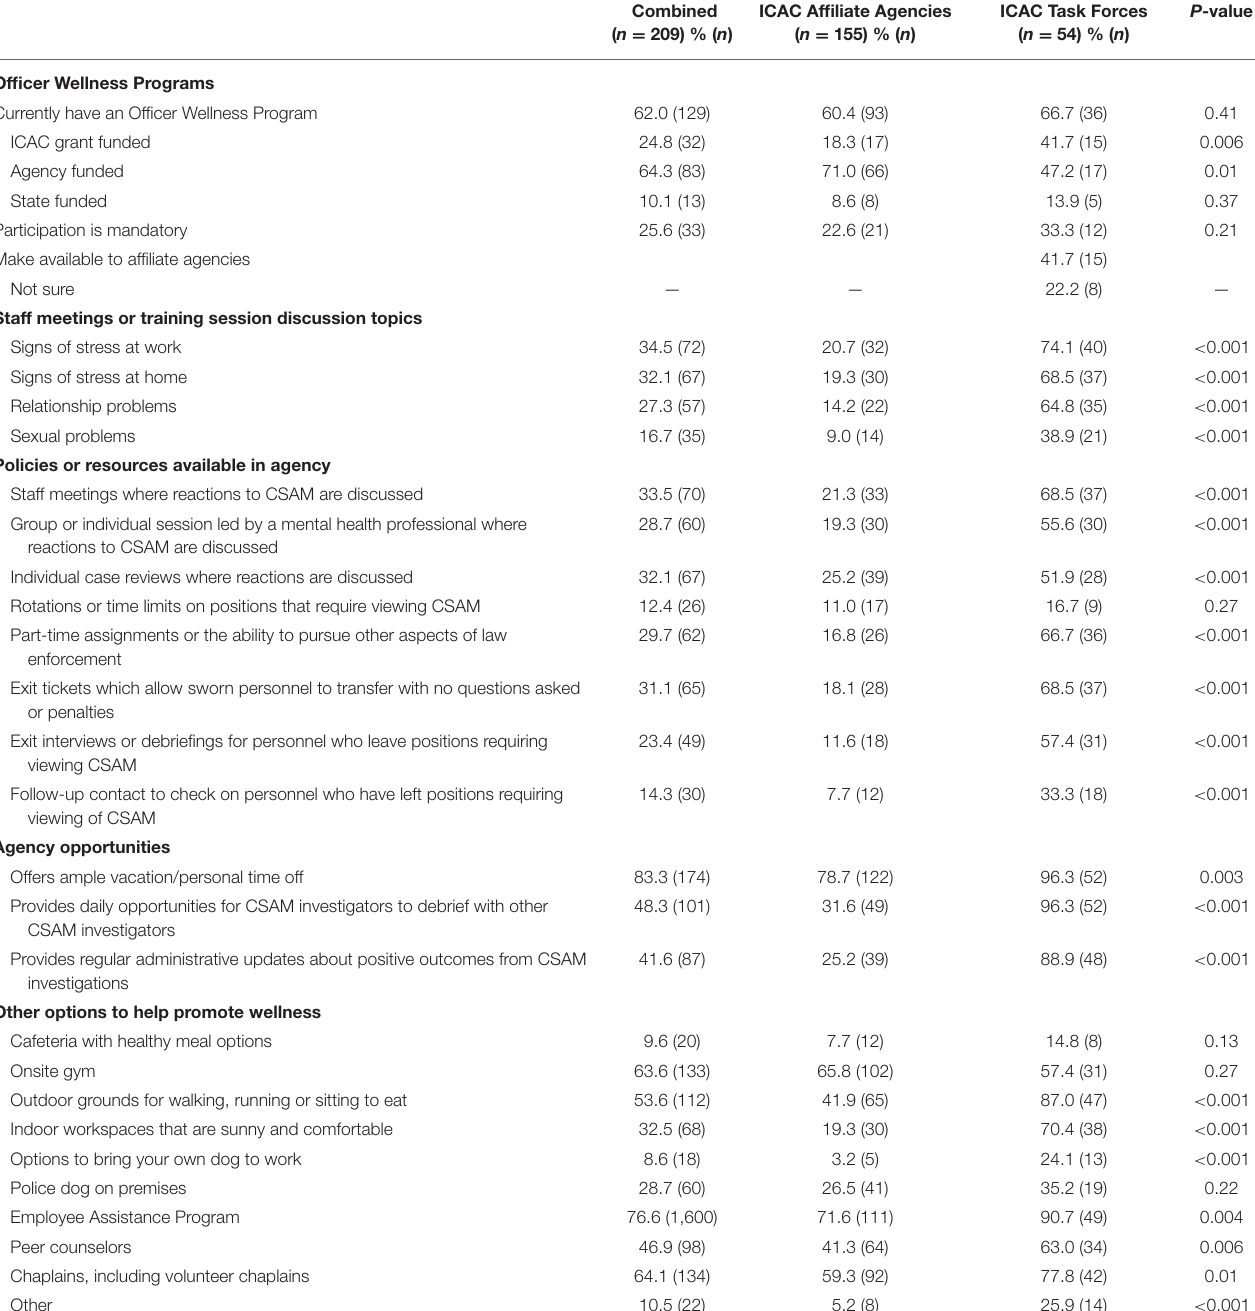
TABLE 2 | Officer Wellness Programs and other strategies for